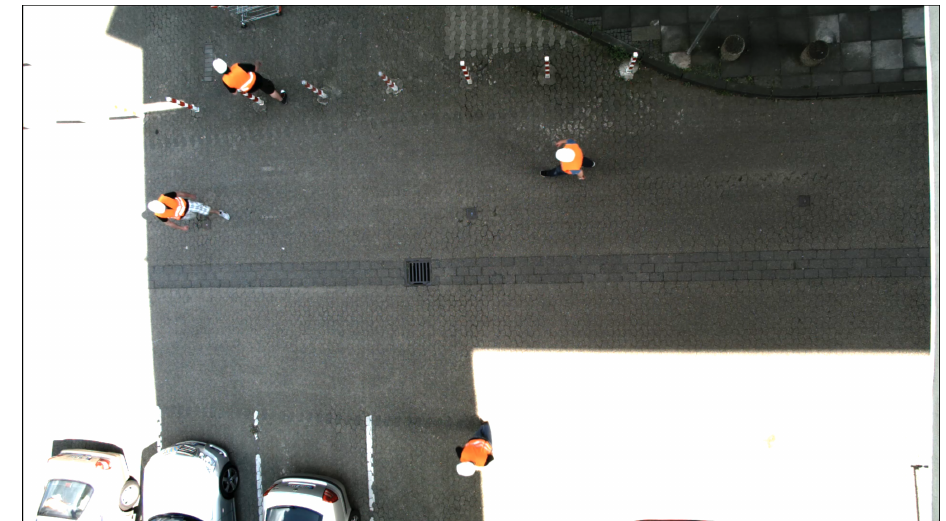
Figure 1. The construction workers are captured by a stationary camera which is located 20m above the ground. The camera is pointed at the ground.